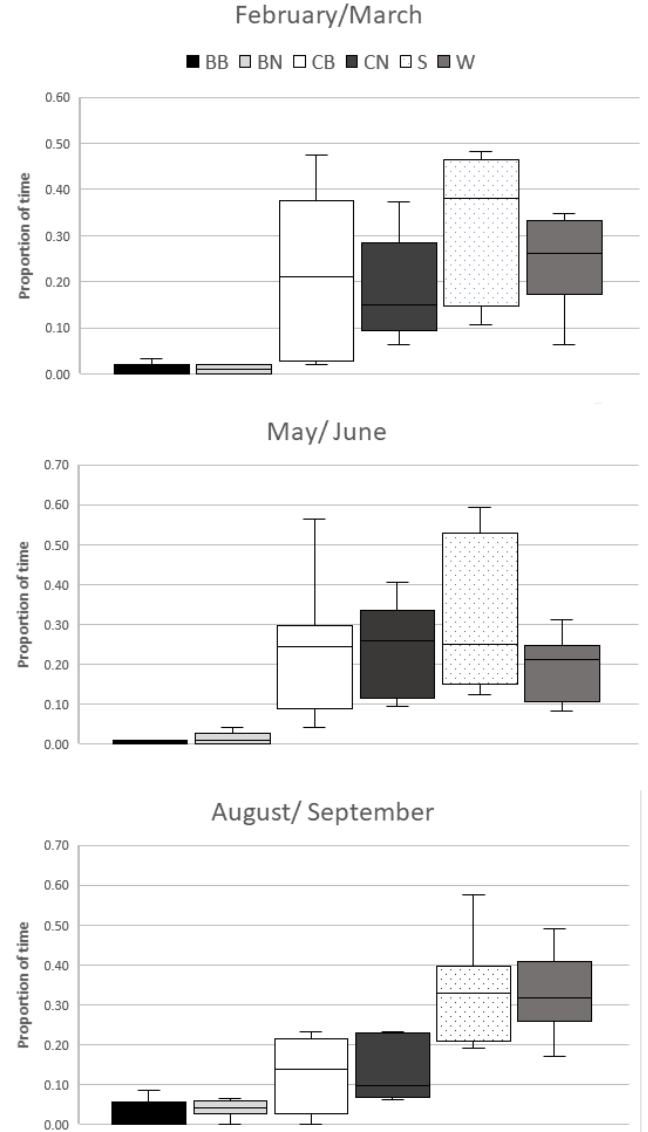
Figure 3. Proportion of time spent in each resource zone, comparing between observation periods; February–March, May–June, and August–September. BB = branches within the bask zone, BN = branches outside of the bask zone, CB = areas of the cork land within the bask zone, CN = cork land areas outside of the bask zone, S = shorelines, including the cork and branches where these meet the water body, W = water body.